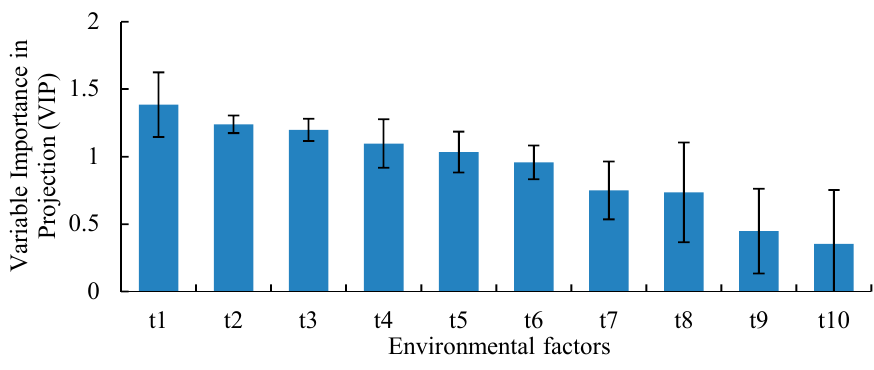
Figure 9. Environmental factors and CO 2 daily exchange in the growing season. ( a ) Temperature; ( b ) Relative humidity; ( c ) Wind speed; ( d ) Sunshine duration; ( e ) Water table level; ( f ) salt content; ( g ) Soil temperature.